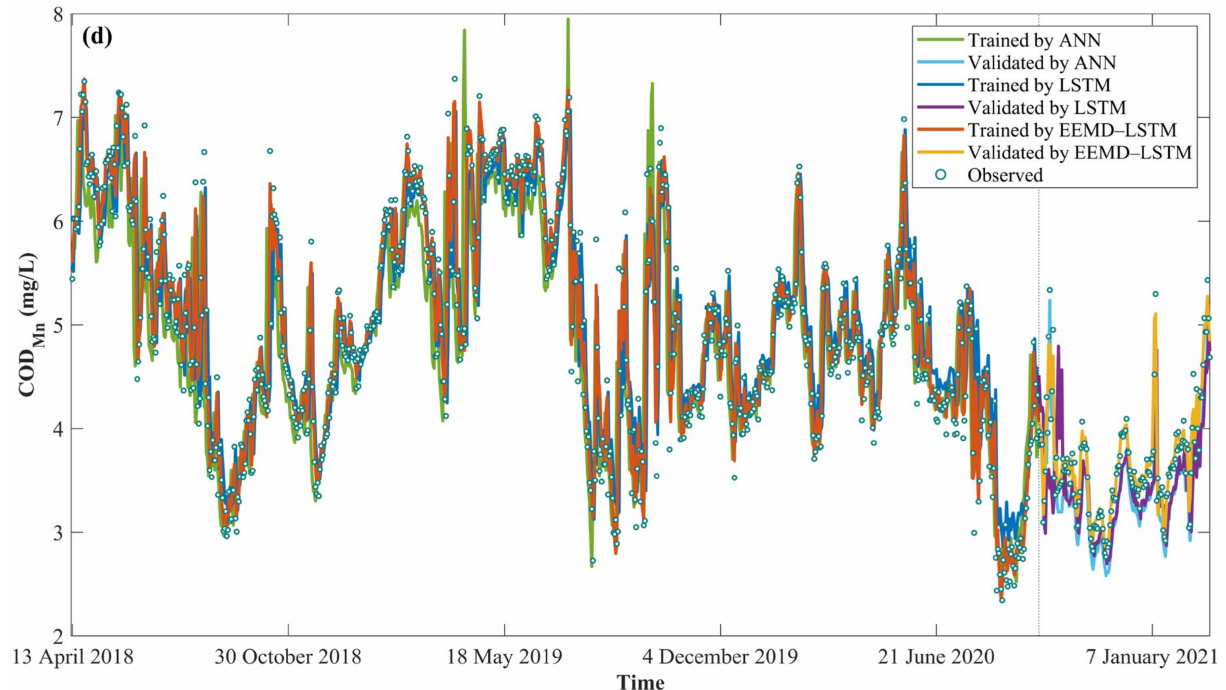
Figure 8. The ANN, LSTM, and EEMD–LSTM prediction results of ( a ) NH 3 -N, ( b ) pH, ( c ) DO, and ( d ) COD Mn . Table 5. Model performance comparison of ANN, LSTM, and EEMD–LSTM.